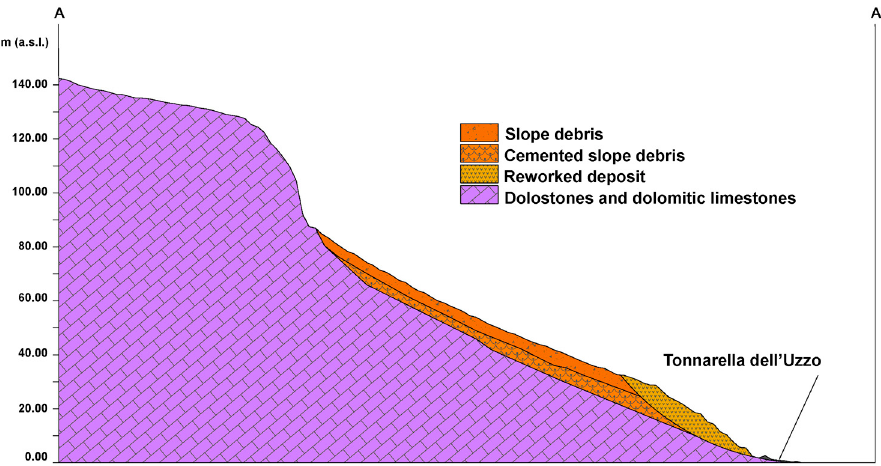
Figure 4. Schematic of geological cross-section (see trace A-A’ in Figure